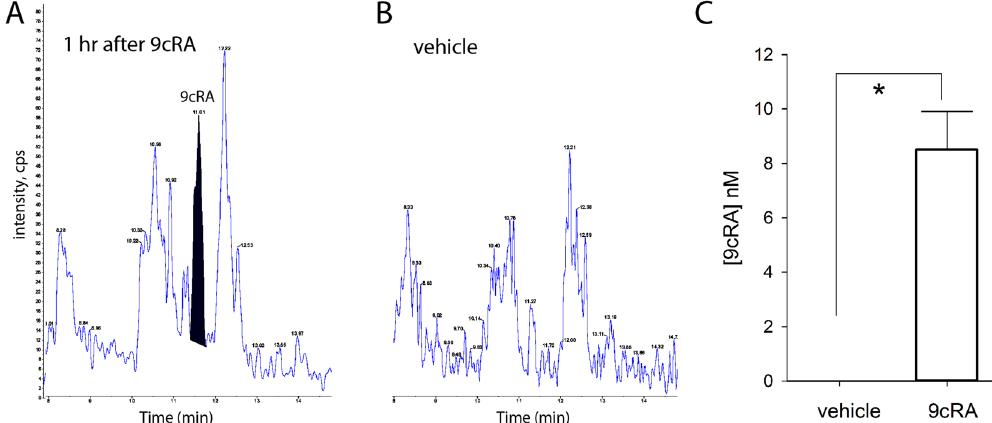
Figure 1. Intranasal delivery of 9cRA Increased 9cRA levels in stroke brain. Stroke rats were given either 9cRA (20 µ g per animal per day, n = 3) or vehicle (n = 3) for 3 days. Brain tissues were collected at 1 hour after the last dose on day 5 for 9cRA levels measurement. Representative chromatographs of brain samples obtained from animals receiving ( A ) 9cRA or ( B ) vehicle. The retention times of the 9cRA and the internal standards were 11.5 and 7.5 min, respectively. ( C ) Intranasal delivery of 9cRA significantly increased 9cRA level in stroke brain ( * p =